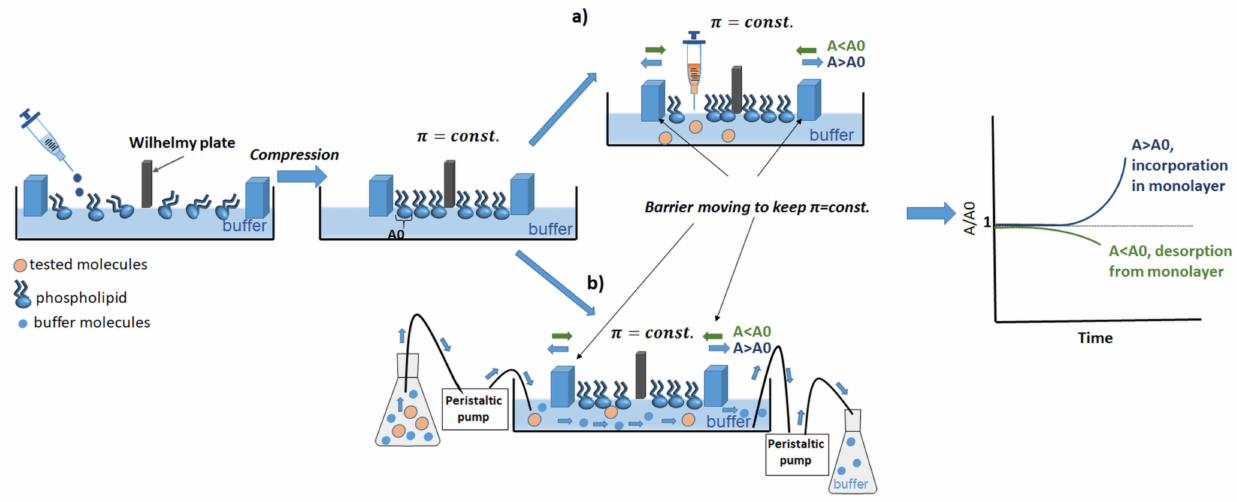
Figure 4. Relaxation of a monolayer by Langmuir technique: ( a ) injection underneath a monolayer into the bulk of the subphase; ( b ) subphase